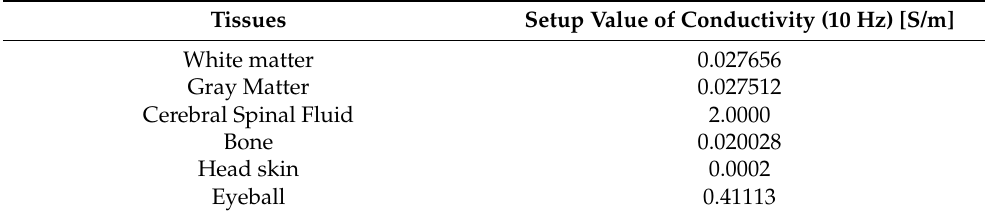
Table 4. The setup electric conductivity value obtained with 10 Hz stimulation